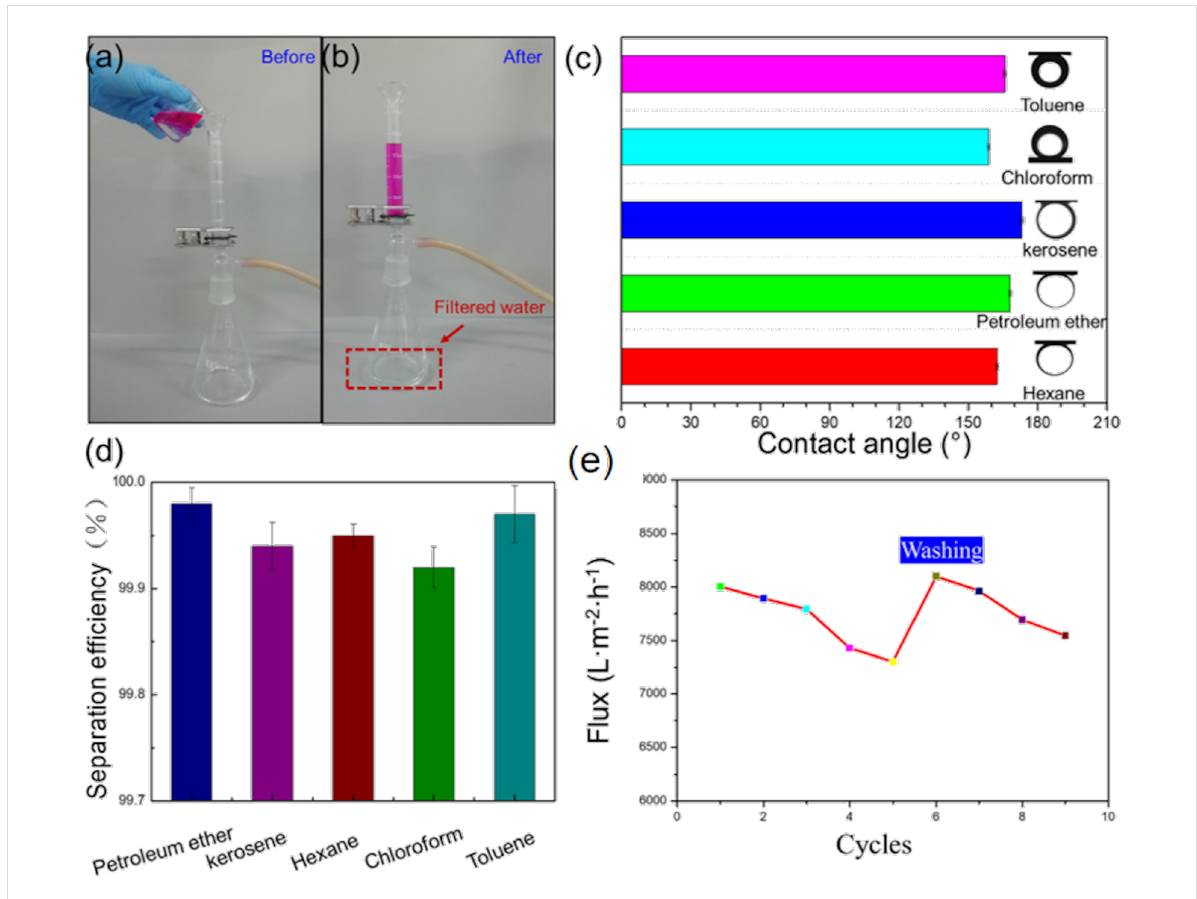
Figure 4: Highly efficient removal of organic chemicals or oils from water (the organic chemicals or oils dyed with red color) (a, b), underwater contact angles of various oils and organic chemicals on the surface of a Pd-decorated polydopamine-SiO 2 /PVA nanofiber membrane (c), separation efficien- cies for various organic chemicals or oil–water mixtures (d). Flux for hexane using a Pd-decorated polydopamine-SiO 2 /PVA nanofiber membrane (e). Figure 4 was reprinted from [83], Journal of Cleaner Production, vol. 275, by H. Yin; J. Zhao; Y. Li; L. Huang; H. Zhang; L. Chen, “A novel Pd deco- rated polydopamine-SiO 2 /PVA electrospun nanofiber membrane for highly efficient degradation of organic dyes and removal of organic chemicals and oils”, article no. 122937, Copyright (2020), with permission from Elsevier. This content is not subject to CC BY